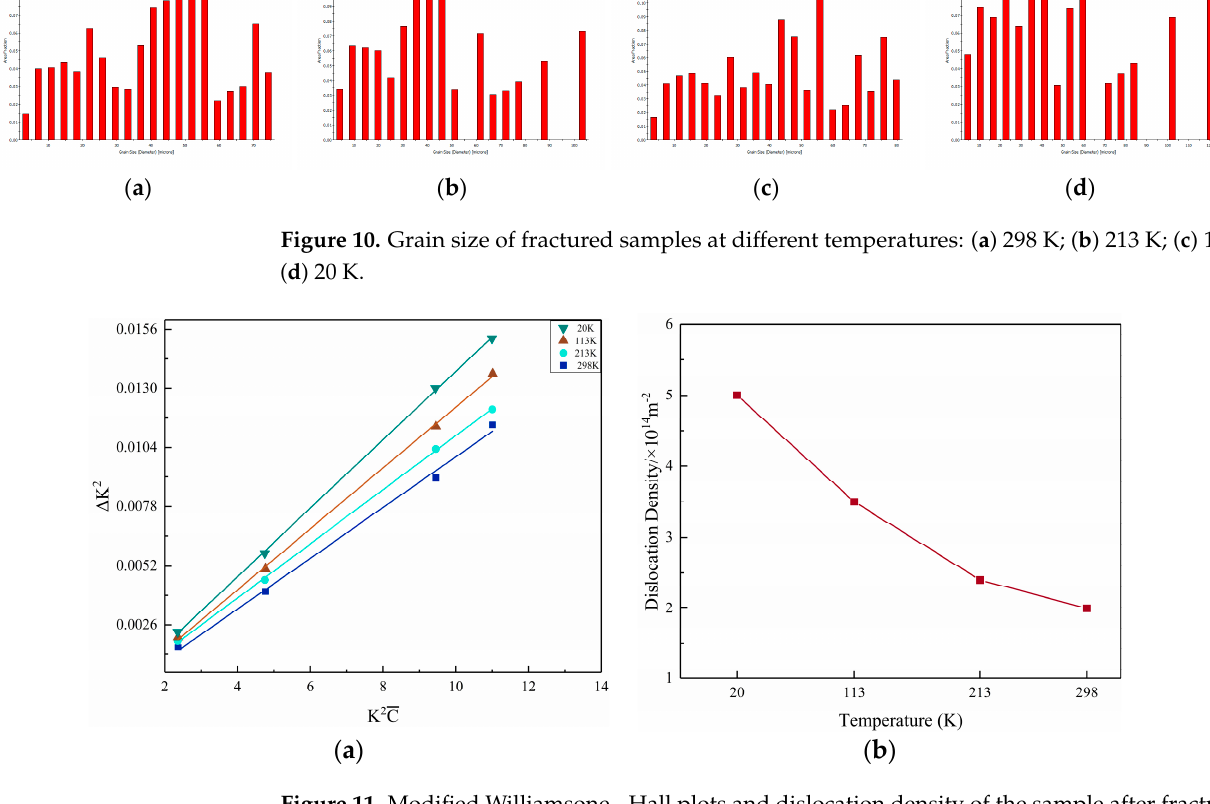
Figure 11. Modi fi ed Williamsone − Hall plots and dislocation density of the sample after fracture at di ff erent temperatures; ( a ) modi fi ed Williamsone − Hall plots; ( b ) dislocation density;. As the temperature decreases, the dislocation densities are 2 × 10 14 m − 2 , 2.4 × 10 14 m − 2 ,